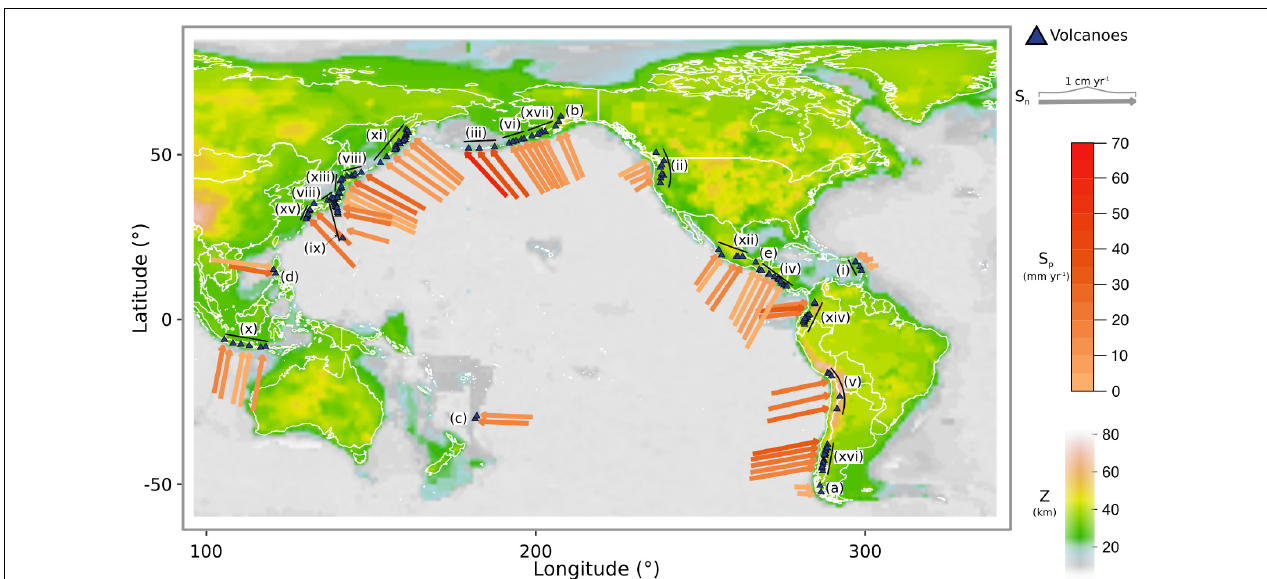
FIGURE 1 | Tectonic and volcanic parameters: (a) Locations of all volcanoes and tectonic vectors used in this study. The length of each arrow is proportional to the rate of subduction normal to the trench (S n ) and the orientation of each arrow represents the angle of subduction. The color of each arrow is contoured for the rate of subduction parallel to the trench (S p ) and the color of the continents is contoured for the modeled crustal thickness (Z). Arcs used in the Bayesian network analysis and regional comparison (i.e., with more than two volcanoes) are labeled using roman numerals: (i) Antilles, (ii) Cascades, (iii) C. Aleutians, (iv) C. America, (v) C. Andes, (vi) E. Aleutians, (vii) Hokkaido-Kuriles, (viii) Honshu, (ix) Izu-Bonin, (x) Java-Bali, (xi) Kamchatka-Kuriles, (xii) Mexico, (xiii) NE. Japan, (xiv) N. Andes (xv) Ryuku, (xvi) S. Andes, and (xvii) W. Alaska. Arcs with two or less volcanoes included only in the Bayesian network analysis are labeled with lower case letters: (a) Austral Andes, (b) Eastern Alaska, (c) Kermadec; (d) N. Philippines, and (e) Chiapanecan.